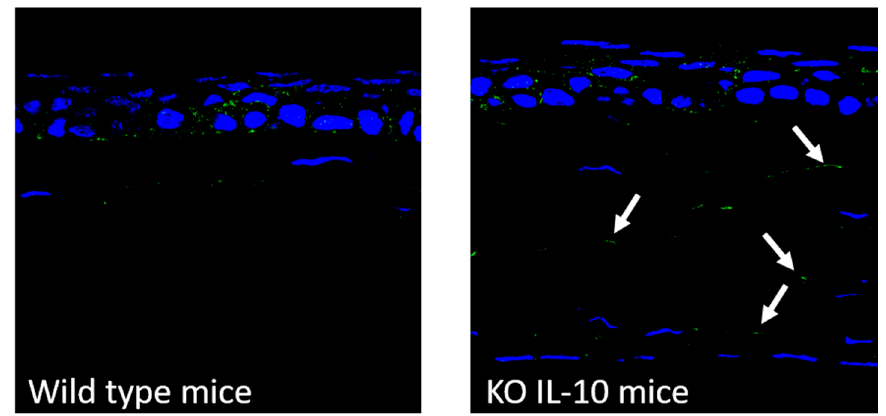
Figure 4. CD44 detection by immunofluorescence in corneal tissue from wild type and IL-10 KO mice (20×). Blue: nuclei stained with DAPI. Green: CD44. KO: knock out; IL-10: interleukin-10.